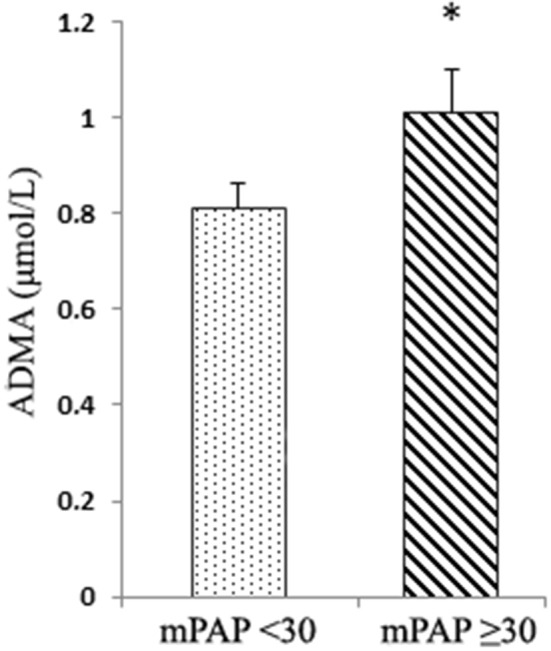
Comparison of ADMA and mPAP (cut-off point < ≥30 mmHg). Asymmetric dimethylarginine (ADMA; μmol/L); mean pulmonary artery pressures (mPAP; mmHg). Values are means (X¯)±SE (standard error); *p < 0.01.